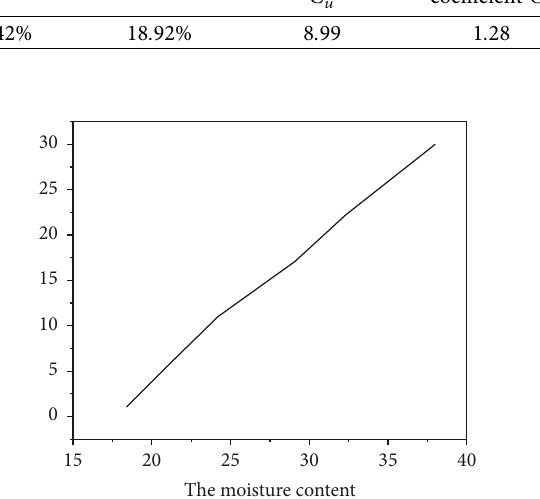
Figure 2: Limit moisture content of soil for the